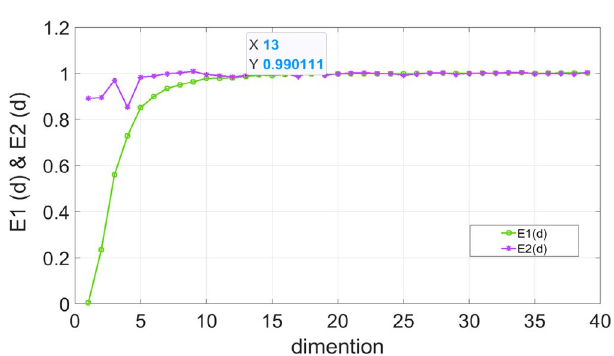
Figure 11. Dimensional determination